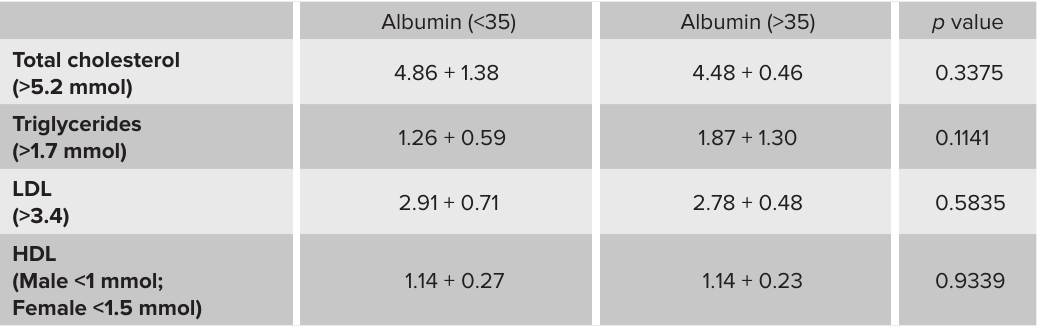
Table 7: The Relationship Between Dyslipidemia and Serum